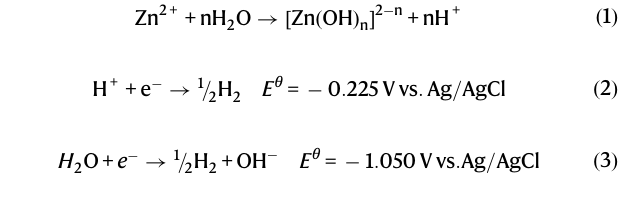
transport limitation for protons and water in the RME. d Cathodic stability and H 2 coevolution behavior for the RME determined by LSV and operando gas pressure measurement. The measurements were performed in a three-electrode cell con- sisting of Ti foil working electrode, activated carbon (AC) counter electrode, and Ag/AgCl reference electrode at scan rate of 1mVs − 1 at